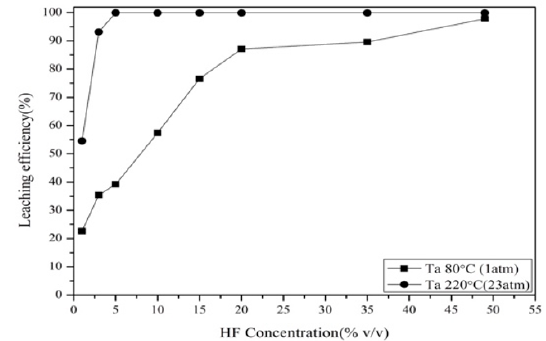
Figure 4. E ff ect of vapor pressure and normal pressure on tantalum leaching e ffi ciency. Liquid–solid ratio: 100 mL per gram; reaction time: 3